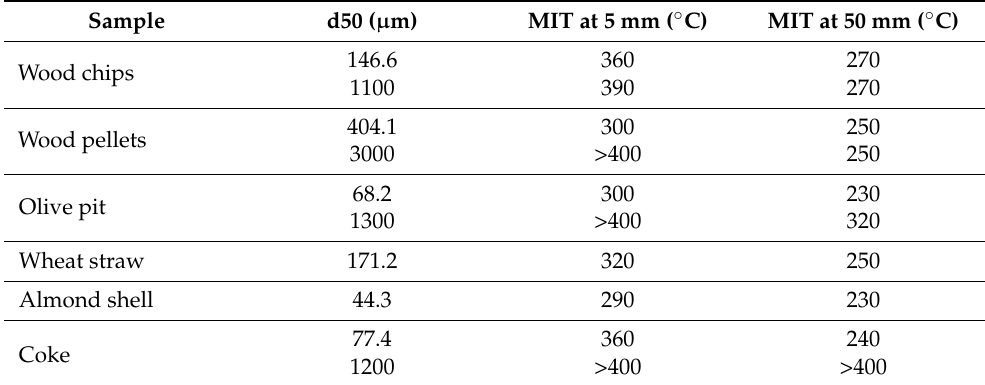
Table 9. Minimum ignition temperature (MIT) of solid samples with different particle sizes